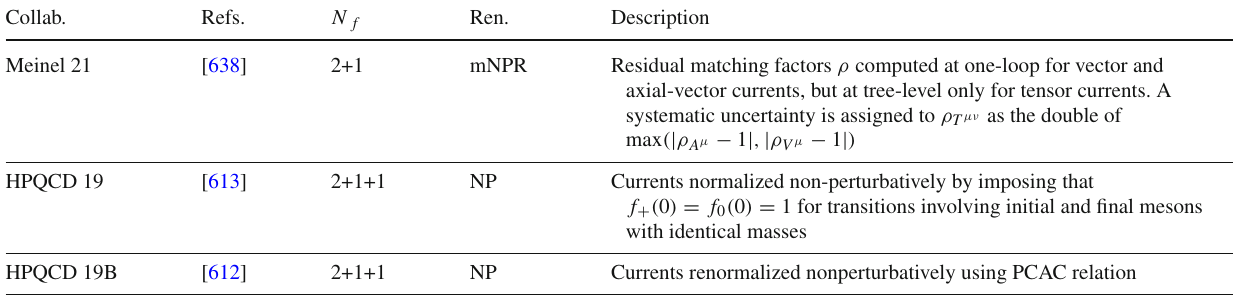
(cid:6)ν and (cid:8) → (cid:8) ( ∗ ) (cid:6) ¯ ν form factors, and of R ( D ( b c s )